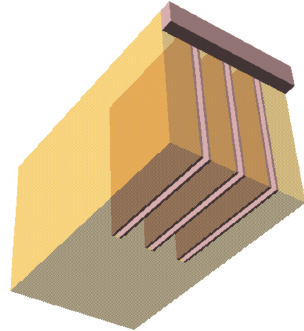
Figure 9. 3D schematic representation of the proposed microstructure showing one busbar and finger structure.